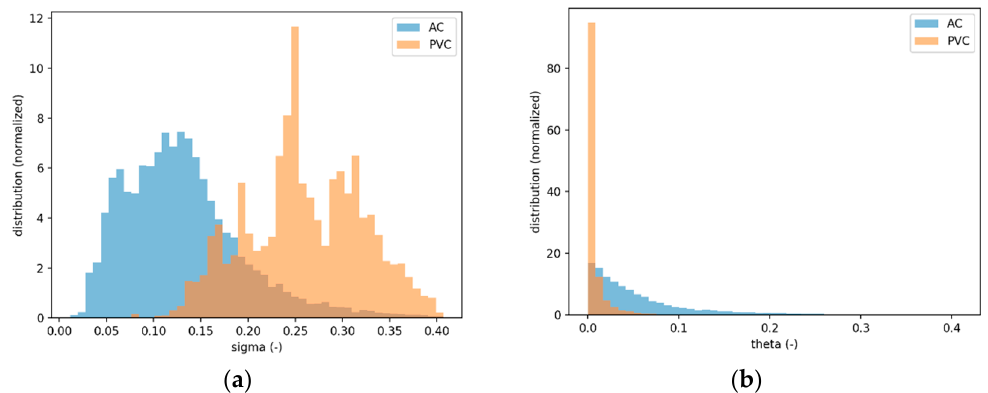
Figure 1. ( a ) Distribution of stresses (sigma) and ( b ) joint rotations (theta) (both normalized with the allowable stress and joint rotation) calculated by Comsima for the distribution network considered in the case